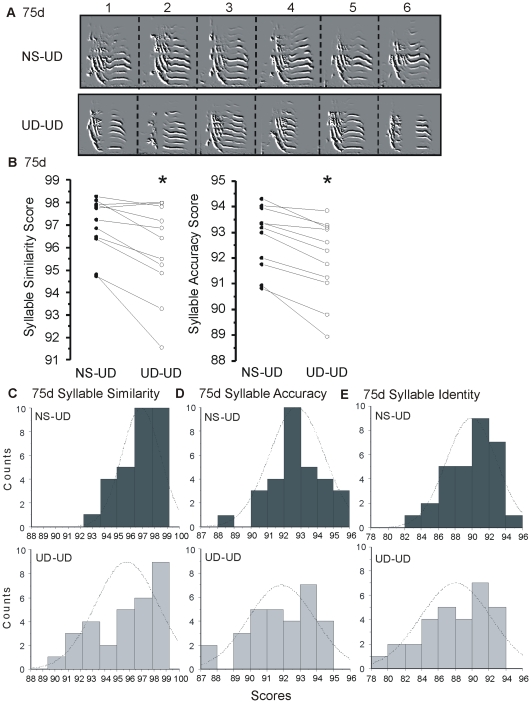
Continuous song practice increases syllable variability at 75d.
A) Examples from one bird at 75d show spectral derivatives of syllables. Six renditions (1–6) of the same syllable are illustrated with time on the x-axis, and frequency on the y axis. In the UD-UD condition, the syllable is composed of two disjointed notes in 1,2,6, but as one continuous note in 3–5 and in all of the NS-UD renditions. B) Paired data scores for the NS-UD (filled circles) and UD-UD (open circles) conditions for each bird are represented by connected lines. The UD-UD condition had lower (*) mean syllable similarity and accuracy scores (p<0.005, p<0.001, 2-tailed paired bootstrap). C–E) Histograms for all 30 syllables representing 11 birds are shown with similarity, accuracy, and identity scores on the x-axis and counts (frequency of occurrence) on the y-axis. The dashed line shows what a fitted curve through a normal distribution would be and is provided for comparison to the actual data. The UD-UD scores (light grey bars) are more broadly distributed and shifted towards lower scores than are the NS-UD scores (dark grey bars) (2-tailed paired bootstrap for similarity, accuracy, and identity, p<0.0001).